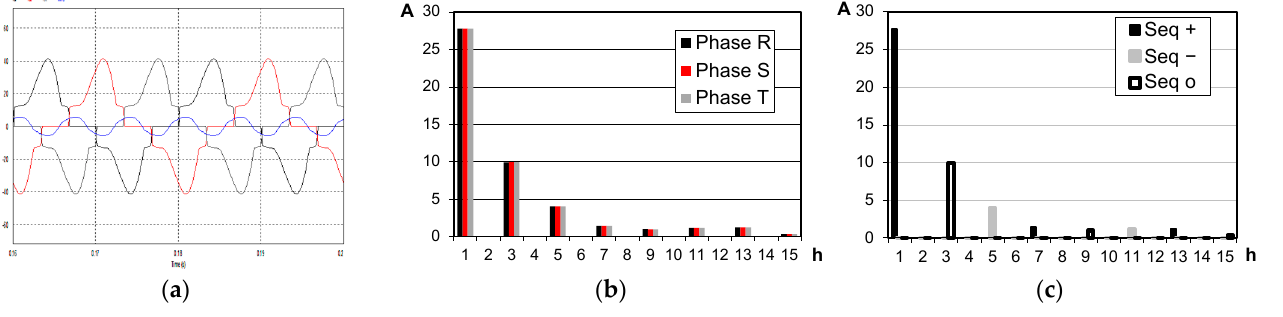
Figure 9. Case A - ( a ) phase current (phases R , S , and T and neutral); ( b ) harmonic spectrum of phase components; ( c ) harmonic spectrum of symmetric components.